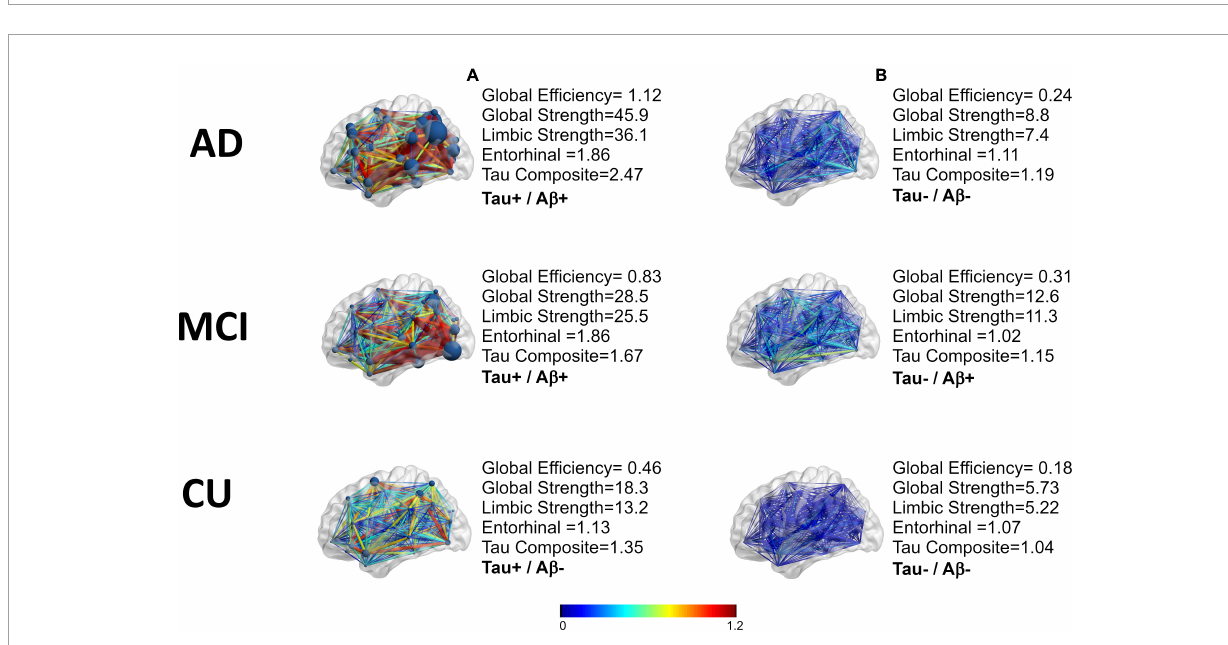
FIGURE3 A representation of the tau networks for two subjects from each of the three clinical groups (AD,MCI, CU). The difference of the means of the weights are in color. The nodal strength can be seen as the size of the nodes. Tau positivity was defined based on the tau composite-SUVR greater than 1.23, (A) are tau positive and (B) are tau negative. A β positivity is defined by mean cortical region to/cerebellar region with a threshold for positivity of